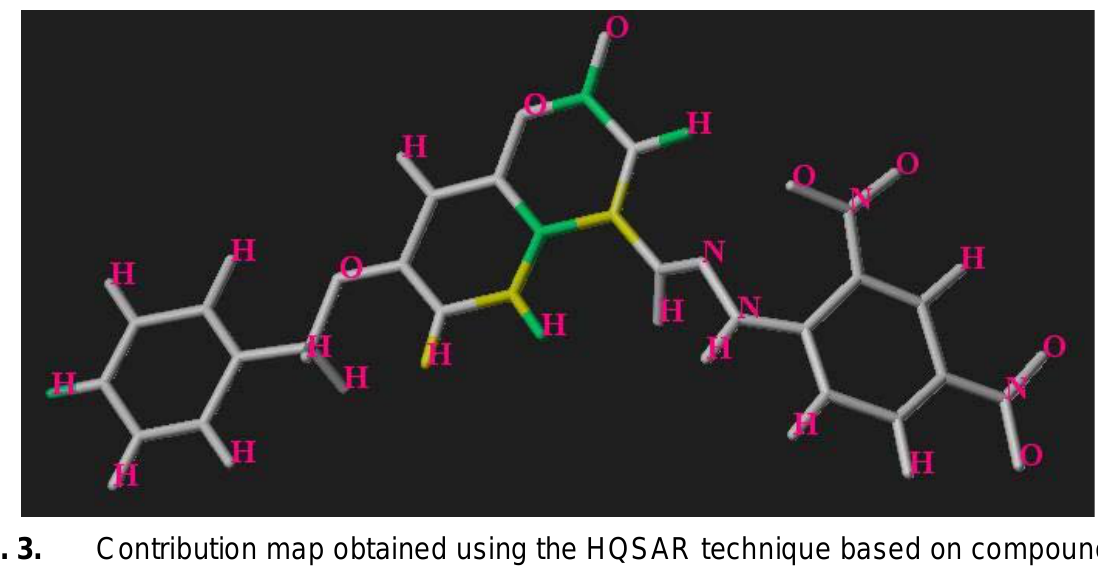
Fig. 3. Contribution map obtained using the HQSAR technique based on compound no. 10 (see text for